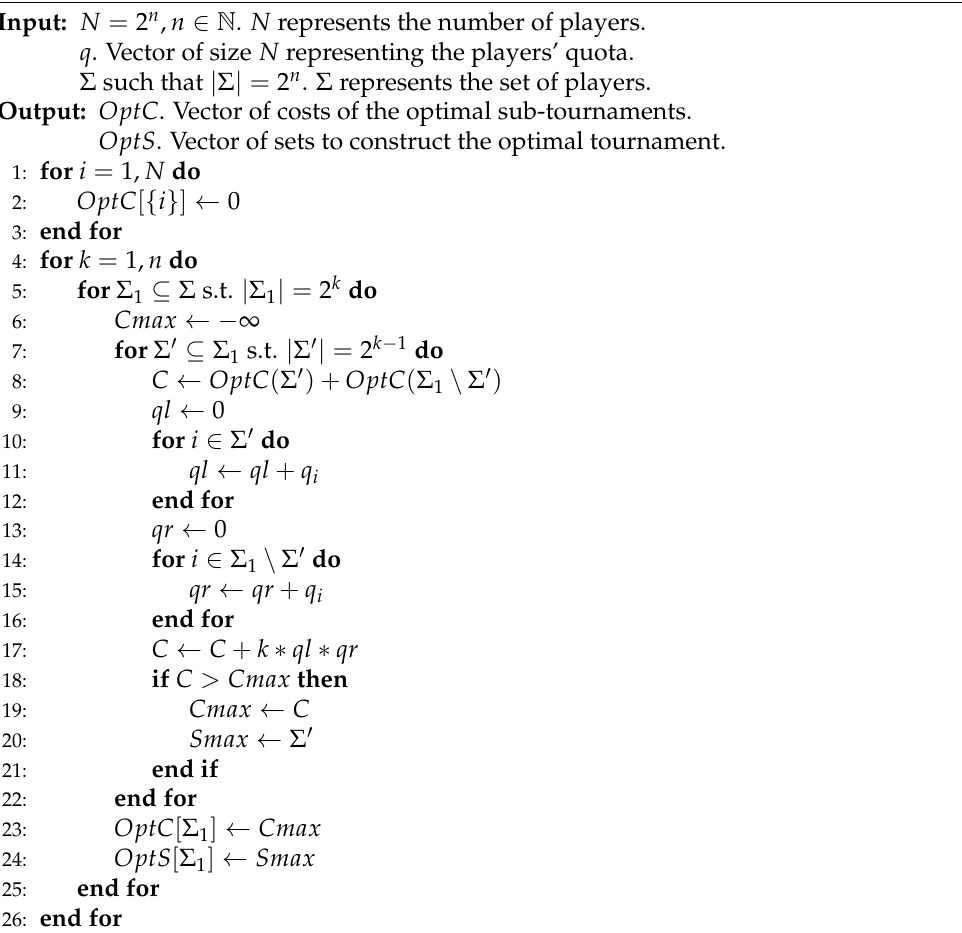
Algorithm 2 OptTourCostBU ( Σ , N = 2 n , q ) bottom up dynamic programming algorithm for computing the cost of optimal fully balanced